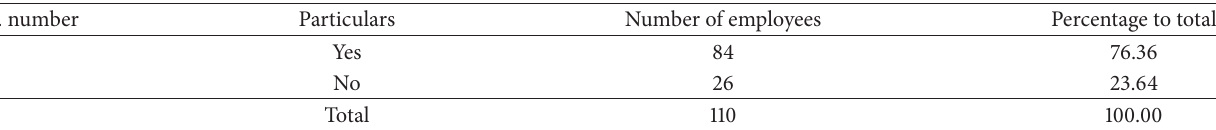
Table 4: Satisfaction with customer services provided by Banking